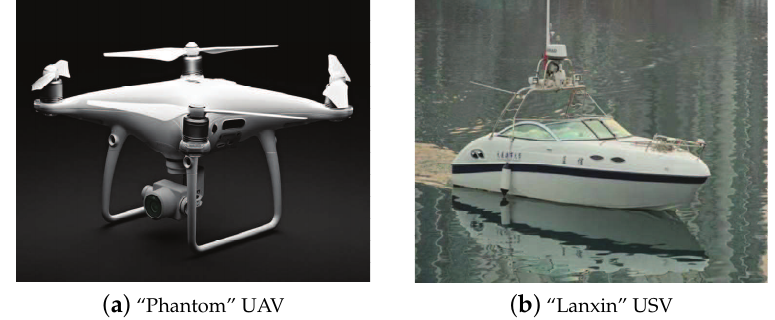
Figure 5. “Phantom” UAV and “Lanxin” USV in the laboratory.